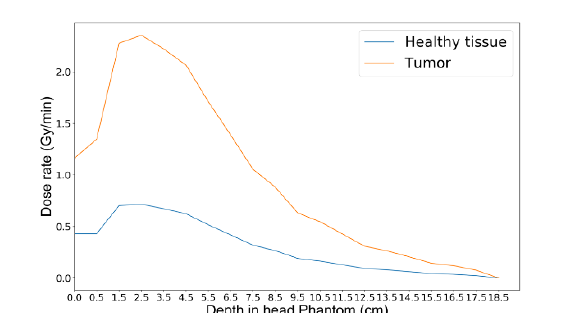
Fig. 12. Dose rate profiles in tumor and healthy